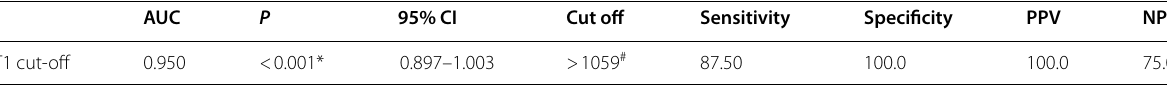
Table 4 Characteristics of the WT1 cutoff for WT1 positivity